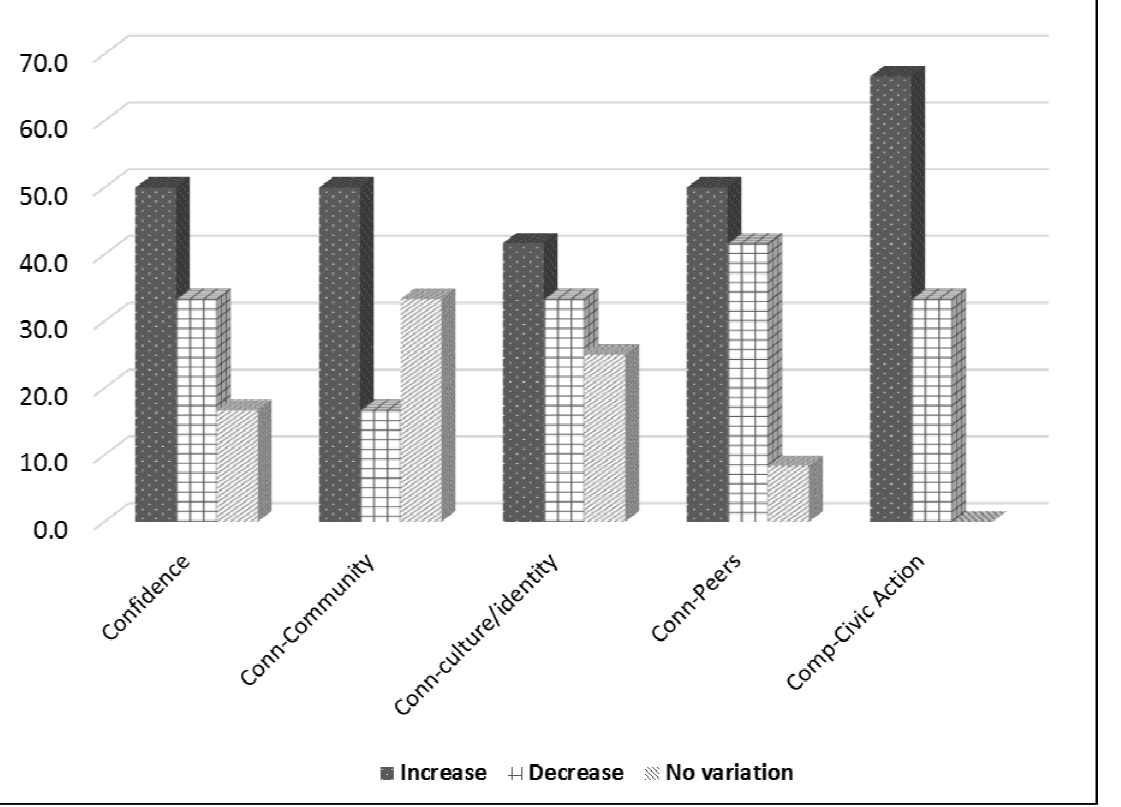
Percent of Overall Participants with Variation in Pre/Post PYD